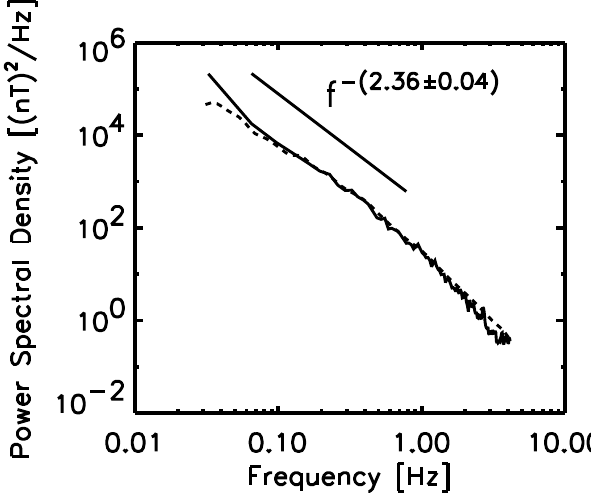
Fig. 3. FFT (continuous line) and wavelet (dashed line) power spec- tra of magnetic field fluctuations shown in Fig.